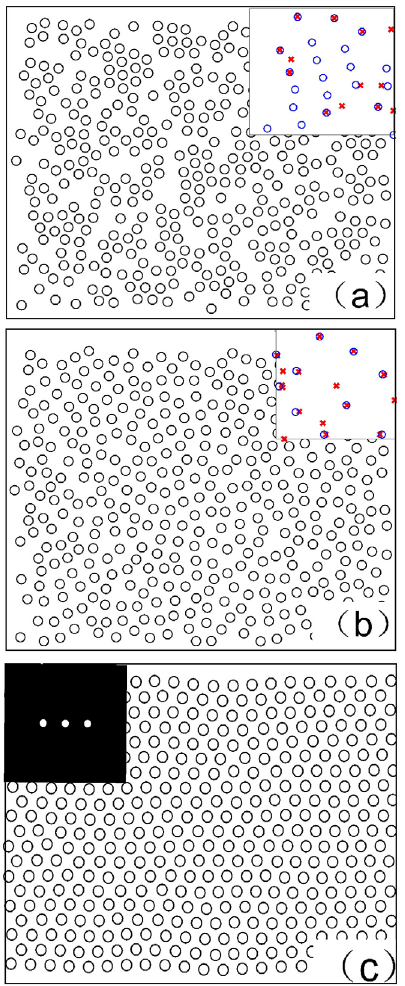
Fig. 4 Coordinates of colloidal particles for (a) 0.01,  A v (b) 1, and (c) 5. The inset of (c) shows its corresponding structure 1 factor defined as c 2 ( ) | exp( ) | N S i      k k R , where N ii c =1 N c is the number of colloidal particles. The insets of (a) and (b) show the snapshots of (a) and (b), respectively, with the substrate pinning centers denoted by crosses.